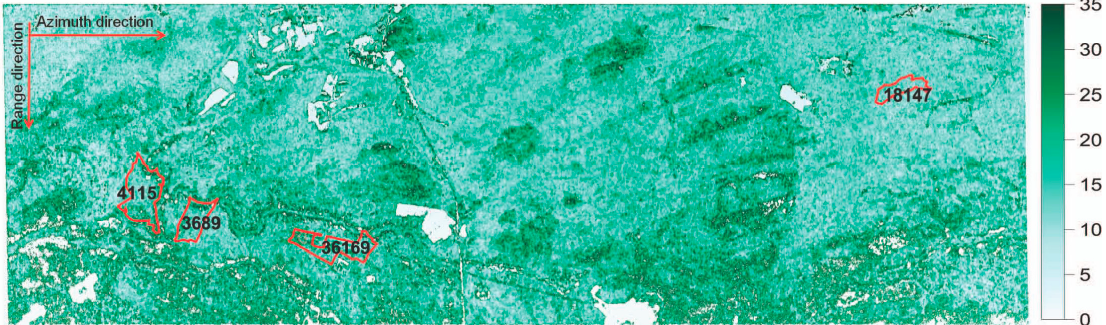
Figure 4. Forest height map of the test site and the location of the selected forest stands. The numbers in the red polygons indicate the sample forest stands with field investigations.